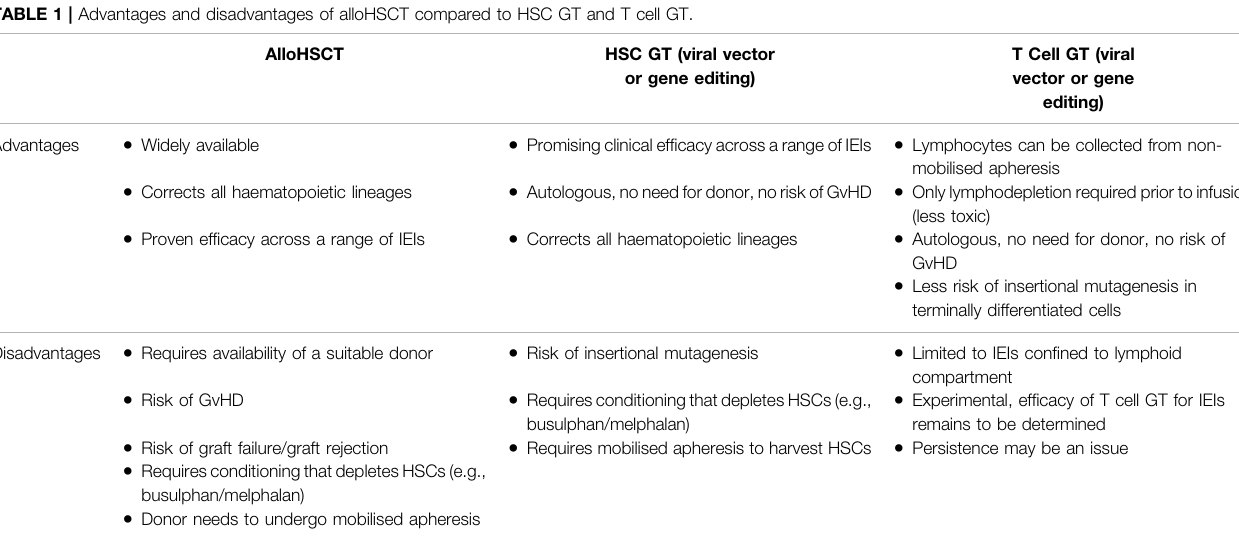
TABLE 1 | Advantages and disadvantages of alloHSCT compared to HSC GT and T cell